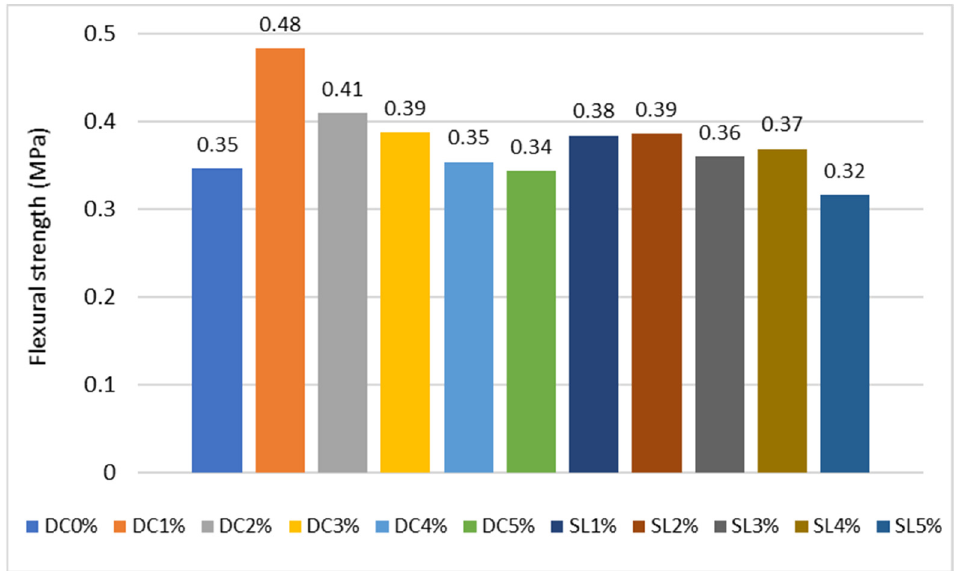
Figure 15. Flexural strength of bricks with saturated fibers. Note: DCi: dynamic compaction for the sample with i (%) of fibers; SLi: static loading for the sample with i (%) of fibers.